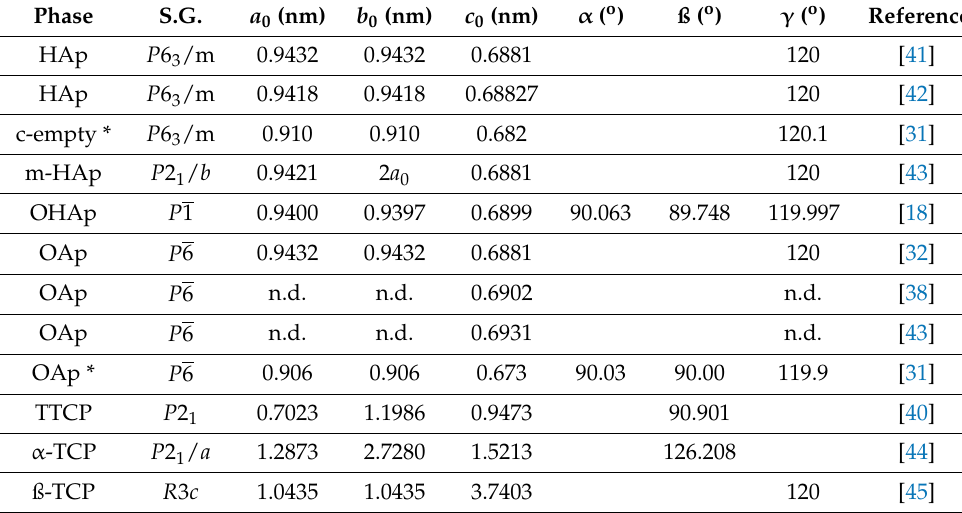
Table 1. Crystallographic data of dehydration and decomposition products of hydroxylapatite.